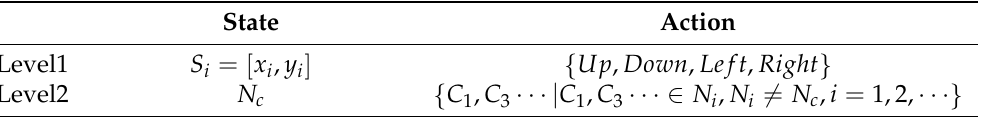
Table 2. The design of the two-layer action and state of the Multi-SARSA